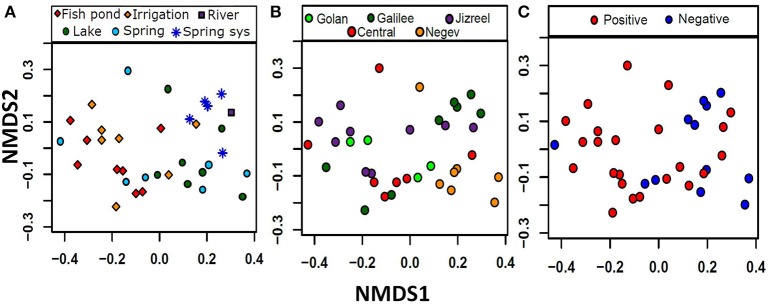
nMDS multivariate analysis indicates grouping of water bodies by geography, water use and mcyD gene presence. The samples ordinate to some extent by both the category or intended use of the water body (A) and the geographic location (B). A statisticaly significante (P = 0.011) separation could also be observed between samples in which mcyD gene presence was observed and those in which is the gene was not detected (C). The nMDS had a stress value of 0.149.